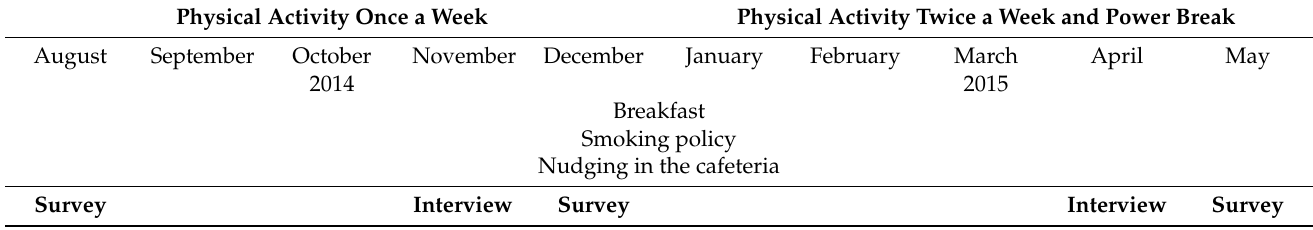
Table 2. Flow of the Whole School Approach